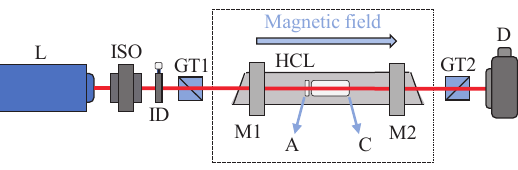
Figure 1. The experimental setup. L: 780 nm laser; ISO: 780 nm isolator; ID: iris diaphragm; GT1 and GT2: Glan–Taylor prisms; HCL: rubidium hollow-cathode lamp; A: the anode of the HCL; C: the cathode of the HCL; M1 and M2: a pair of permanent magnets; D: